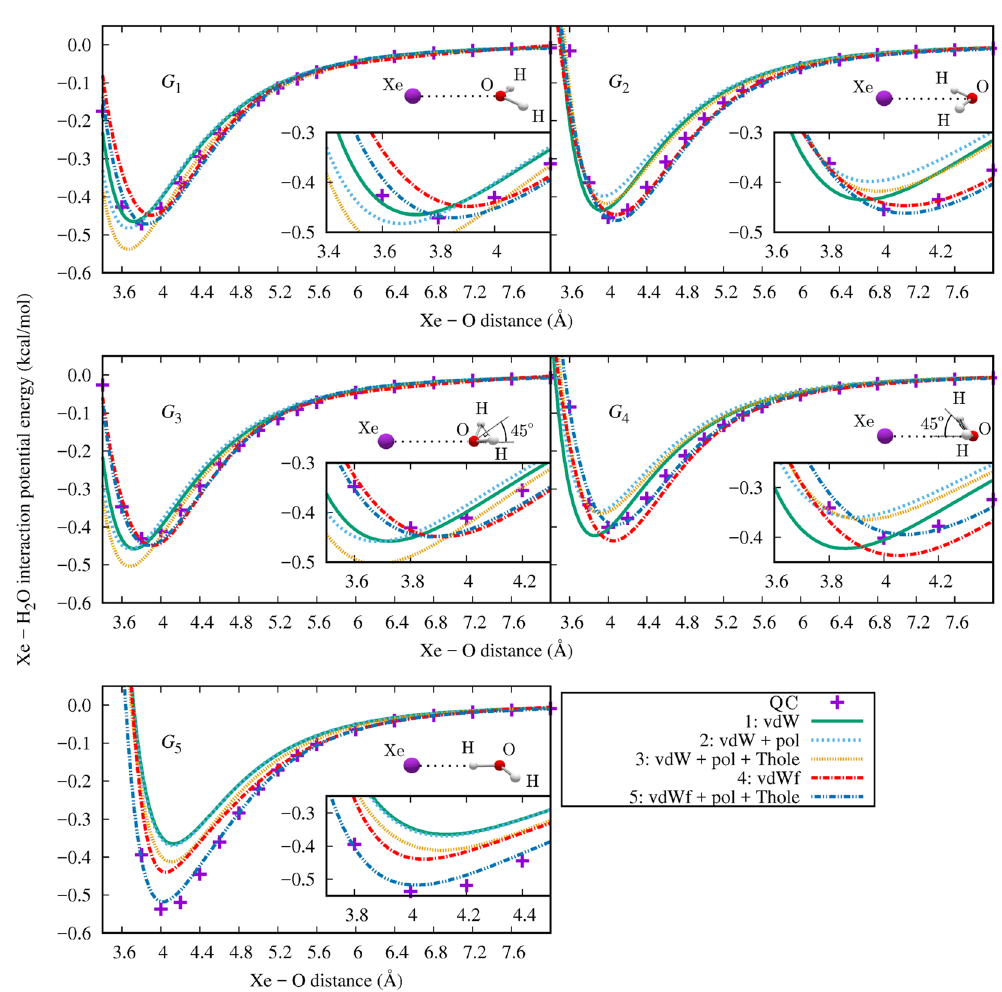
Figure 2. Fits of the Xe–H 2 O potential to the ab initio calculations (QC) with the following parameters adjusted. 1: AMOEBA van der Waals parameters; 2: van der Waals and polarizability; 3: van der Waals, polarizability, and Thole parameters; 4: coefficients C n in the van der Waals potential of Eq. (S1) in the Supplementary Information; 5: polarizability, Thole factor, and the coefficients C n . The insets show the orientations of the Xe–H 2 O dimer for each curve